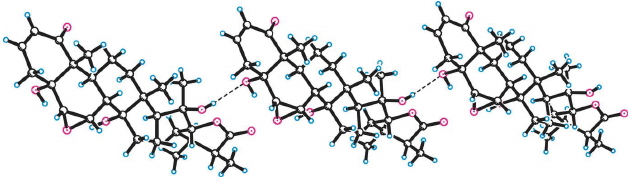
Figure 4 O20—H20 (cid:2)(cid:2)(cid:2) O5 hydrogen bonds in the crystal structure of compound II (the molecules are cross-linked along the c axis).